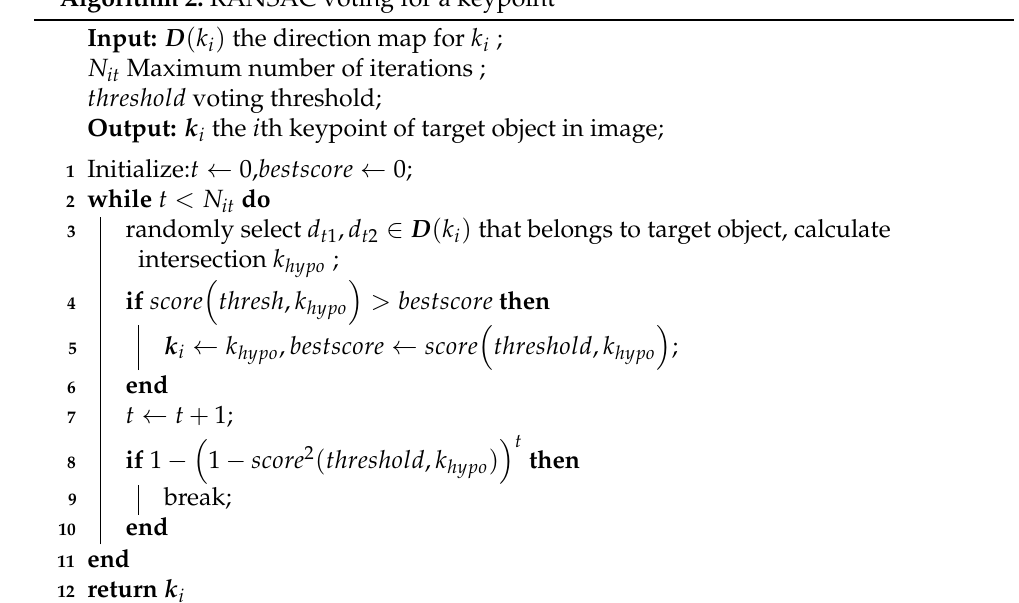
Algorithm 2: RANSAC voting for a